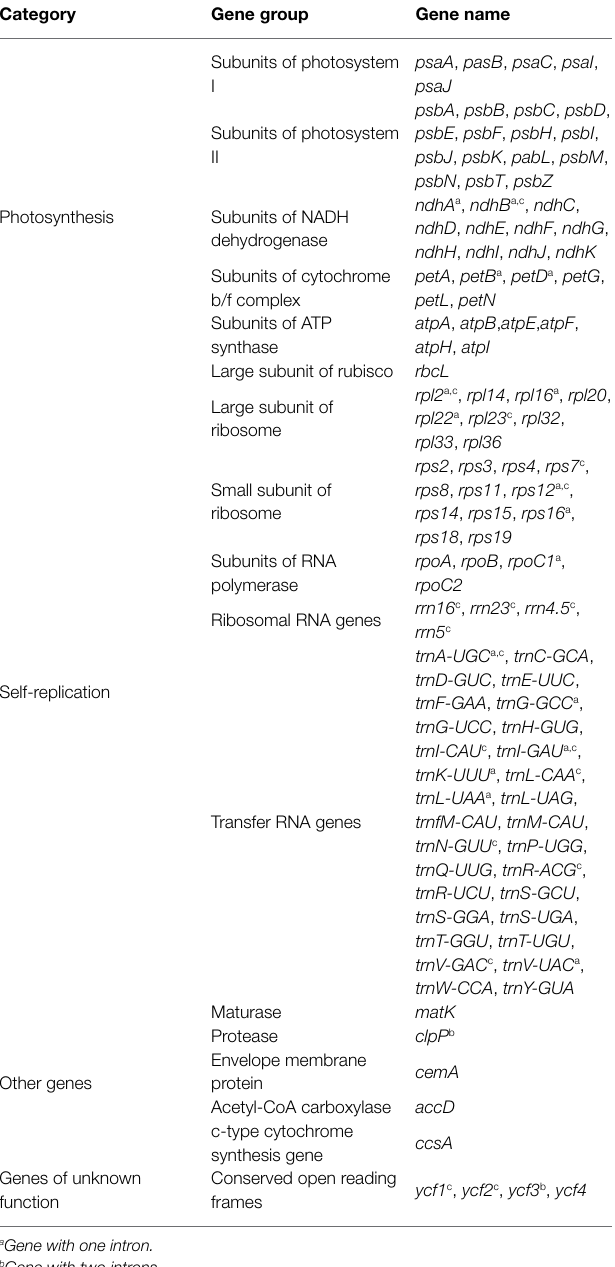
TABLE 3 | Genes in the Fragaria chloroplast